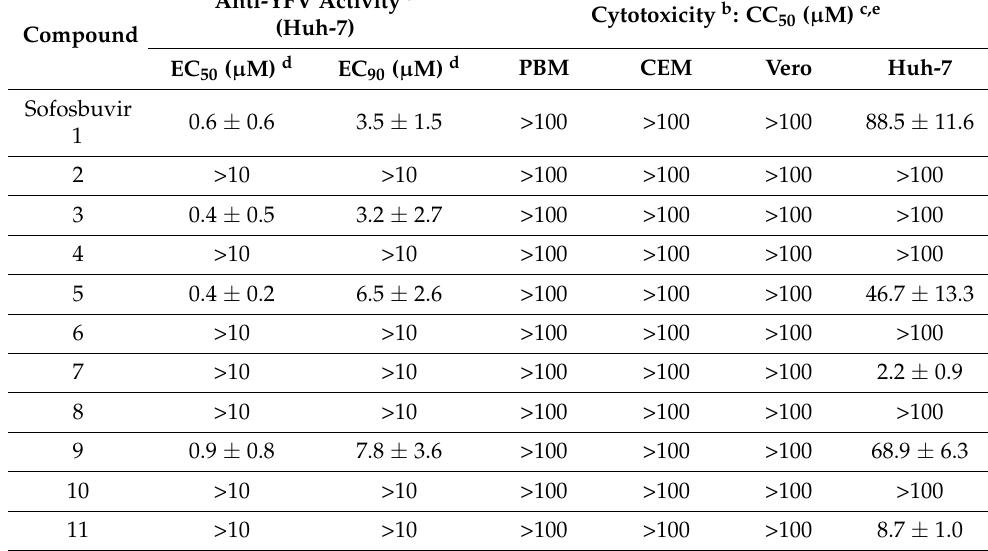
Table 1. Antiviral Activity and Cytotoxicity of Compounds 1-11.